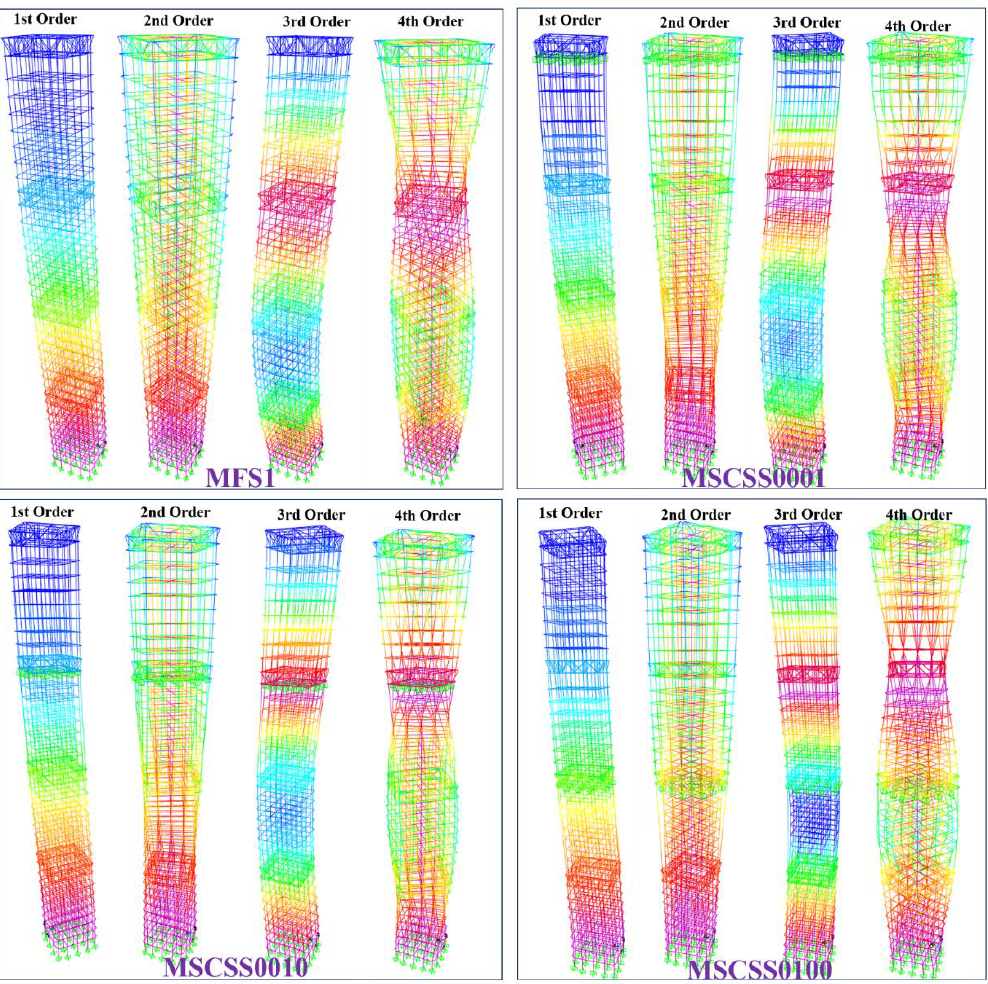
Figure 3. The modal analysis of the designed MSCSS configurations together with the conventional MFS one.